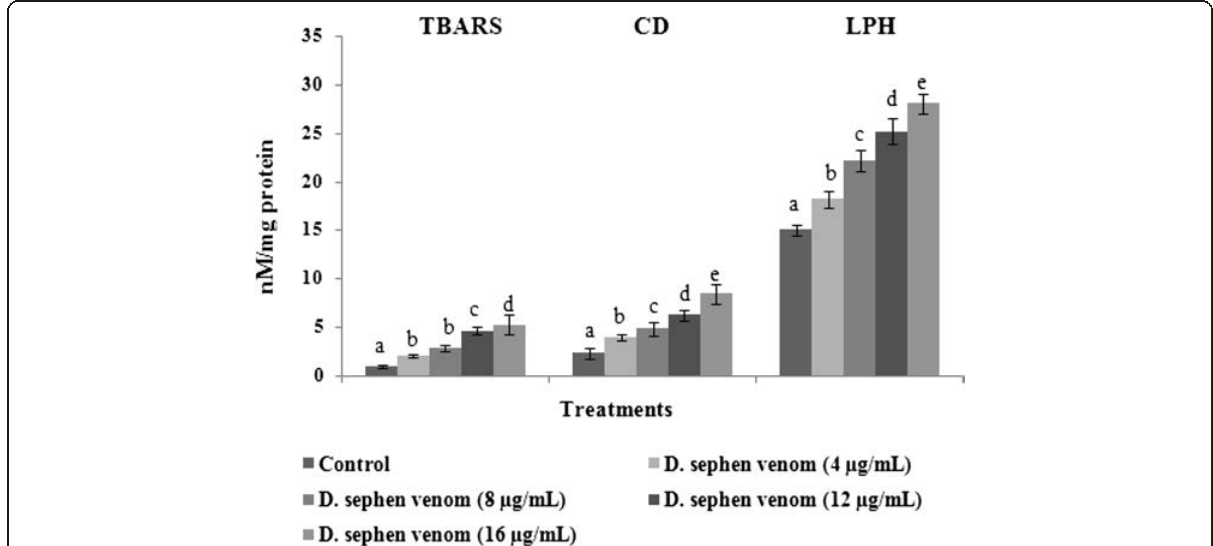
Fig. 3 Effect of D. sephen venom on lipid peroxidation in HeLa cells. Bars represent the changes on the levels of lipid peroxidative markers (TBARS, CD and LPH) in HeLa cells. Values were given as mean ± SD of six experiments in each group. Values not sharing the same letter differ significantly ( p < 0.05) from control